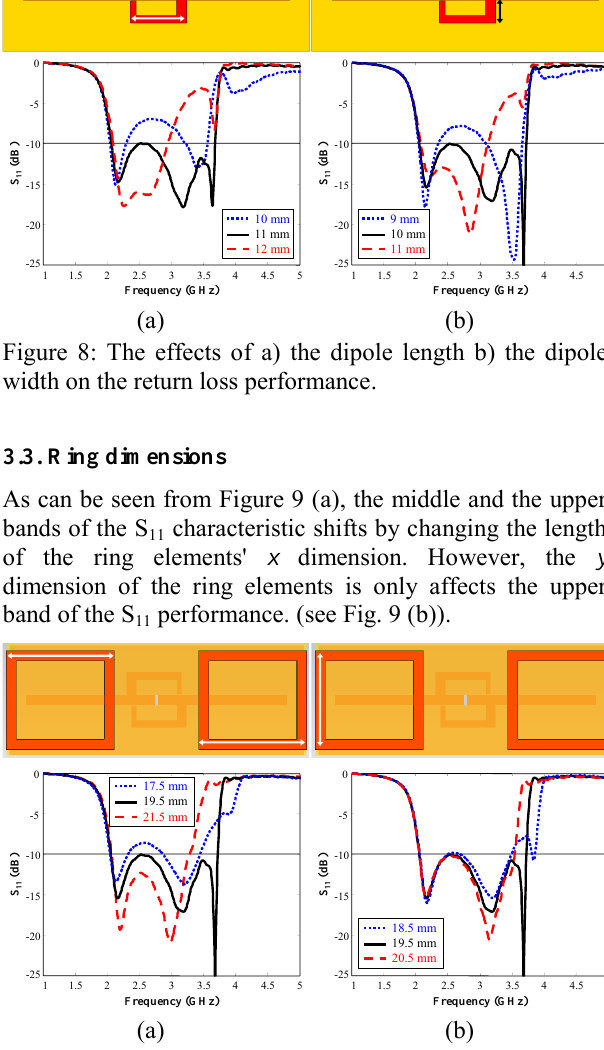
Figure 9: The effects of a) the ring elements’ x dimensions b) the ring elements y dimensions on the return loss